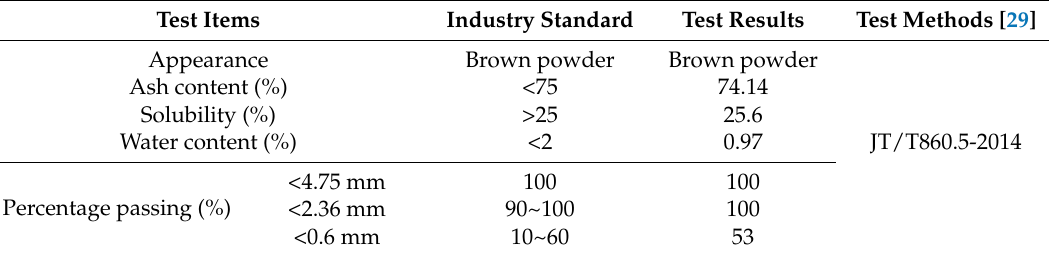
Table 2. Technical properties of BRA.